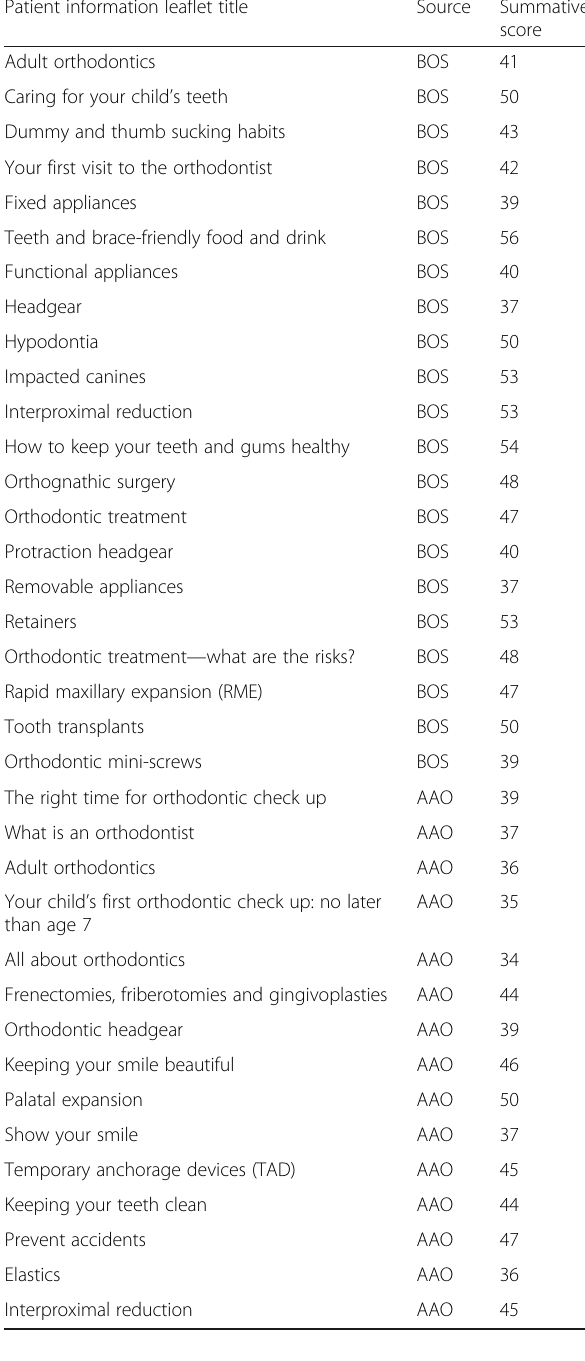
Table 2 The summative DISCERN score for each PIL